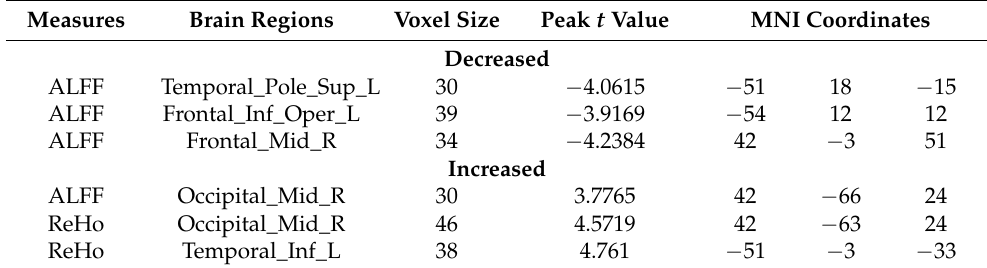
Table 5. Significant differences in ALFF and ReHo of MDDs pre/post ECT.